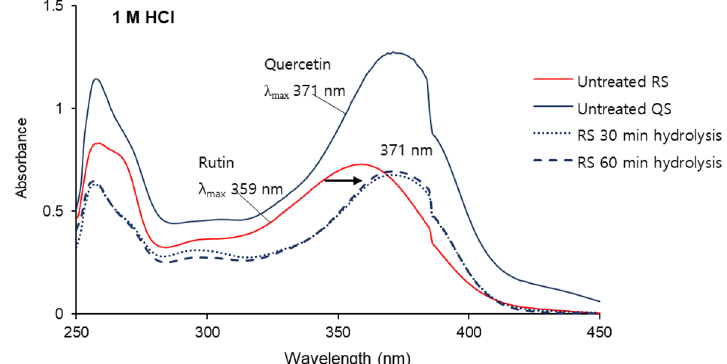
Fig. 6 UV spectra of Rutin standard (RS) hydrolyzed with 1 M HCl and Quercetin standard